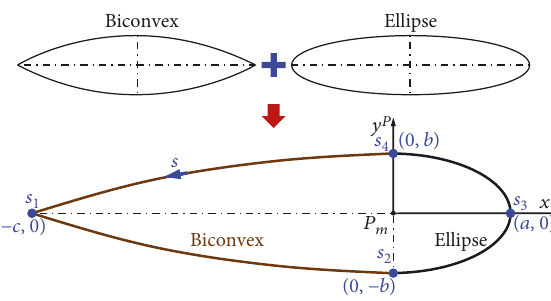
Figure 1: A chordwise asymmetric closed cross-section.